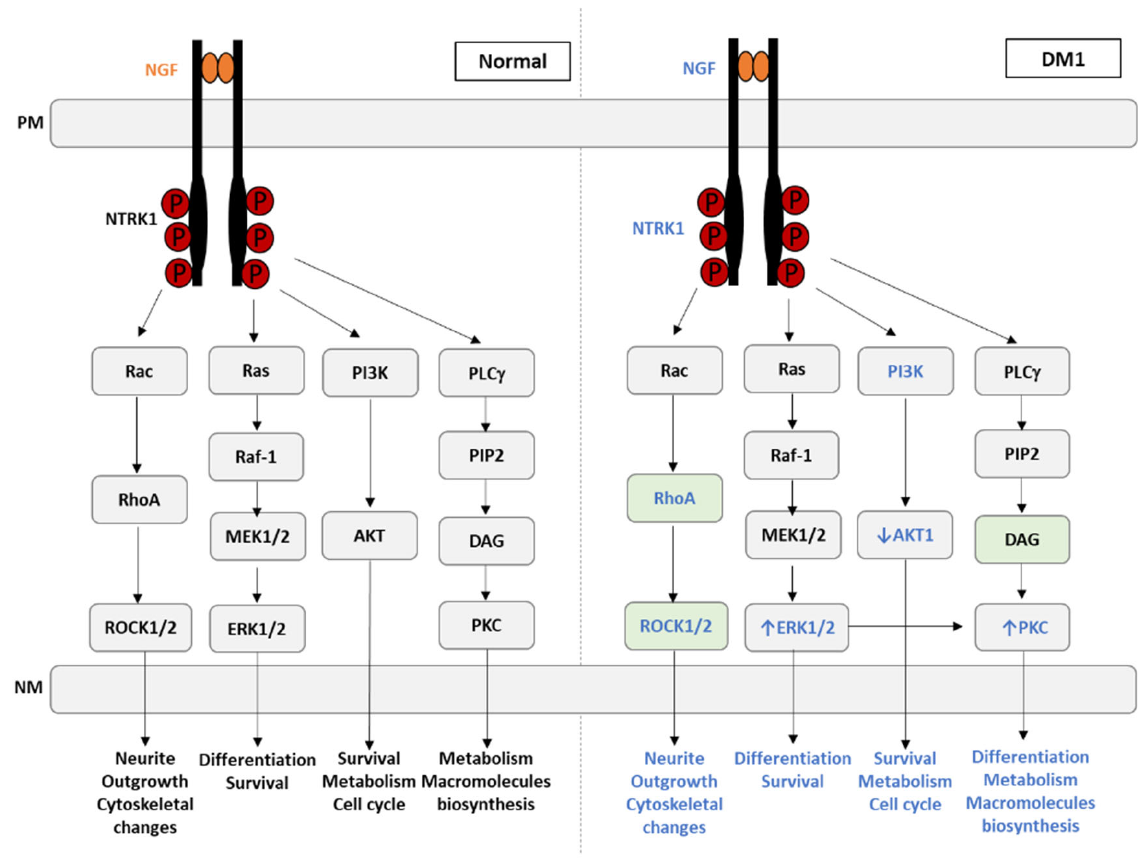
Figure 7. NGF ‐ mediated TRK receptor dimerization and activation of three main intracellular signaling pathways under normal conditions and its deregulation in myotonic dystrophy type 1. The eight genes found in our analysis associated with the TRK signaling pathways are identified in blue, as well as the biological processes affected in DM1. The green boxes indicate the genes never associated with DM1. PM, plasma membrane; NM, nuclear membrane; NGF , nerve growth factor; NTRK1 , neurotrophic receptor tyrosine kinase 1; RAC, Ras ‐ related C3 botulinum toxin substrate 1; RAS, rat sarcoma; PI3K , phosphoinositide 3 ‐ kinase; PLC ‐γ , phospholipase C gamma; RhoA , Ras homolog family member A; Raf1, Raf ‐ 1 proto ‐ oncogene, serine/threonine kinase; PIP2 , phosphatidylinositol 4,5 ‐ bisphosphate; MEK1/2, MAP kinase kinases MEK ‐ 1 and MEK ‐ 2; AKT, protein kinase B; DAG, diacylglycerol; ROCK1/2 , Rho ‐ associated protein kinase 1/2; ERK1/2, extracellular signal ‐ regulated protein kinase; PKC, protein kinase C.